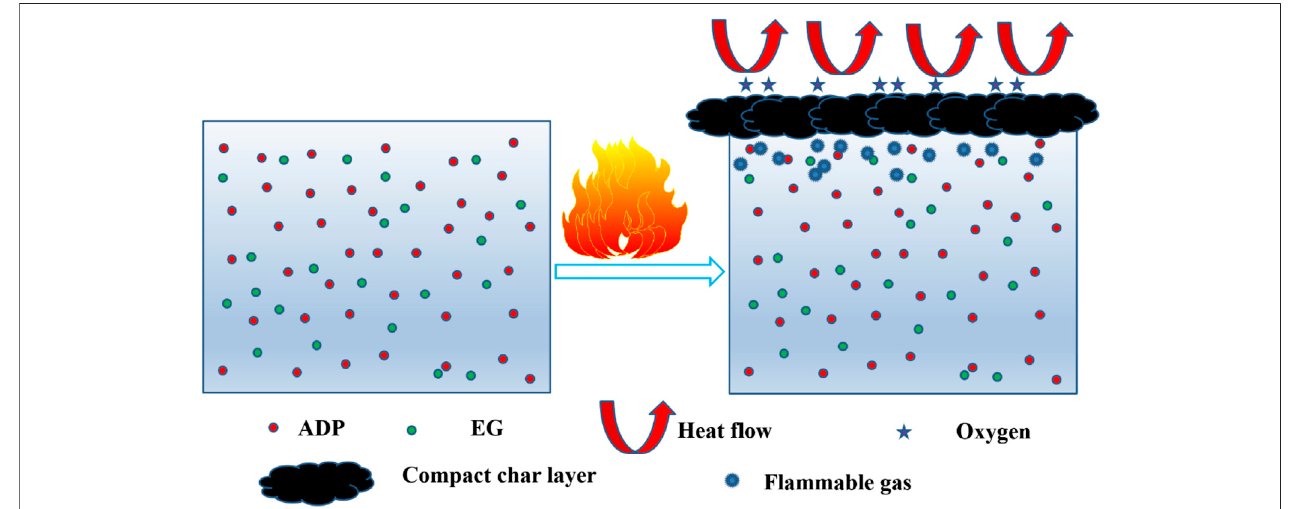
FIGURE 8 | Schematical illustration of fl ame retardant mechanism for RPUF/ADP/EG composites.